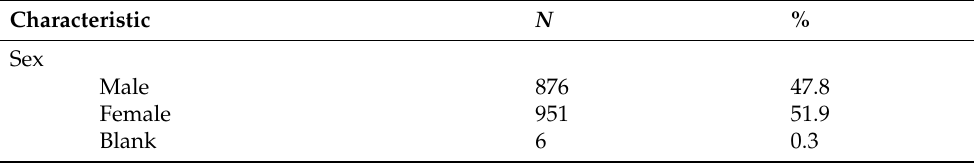
Table 2. Alberta sample